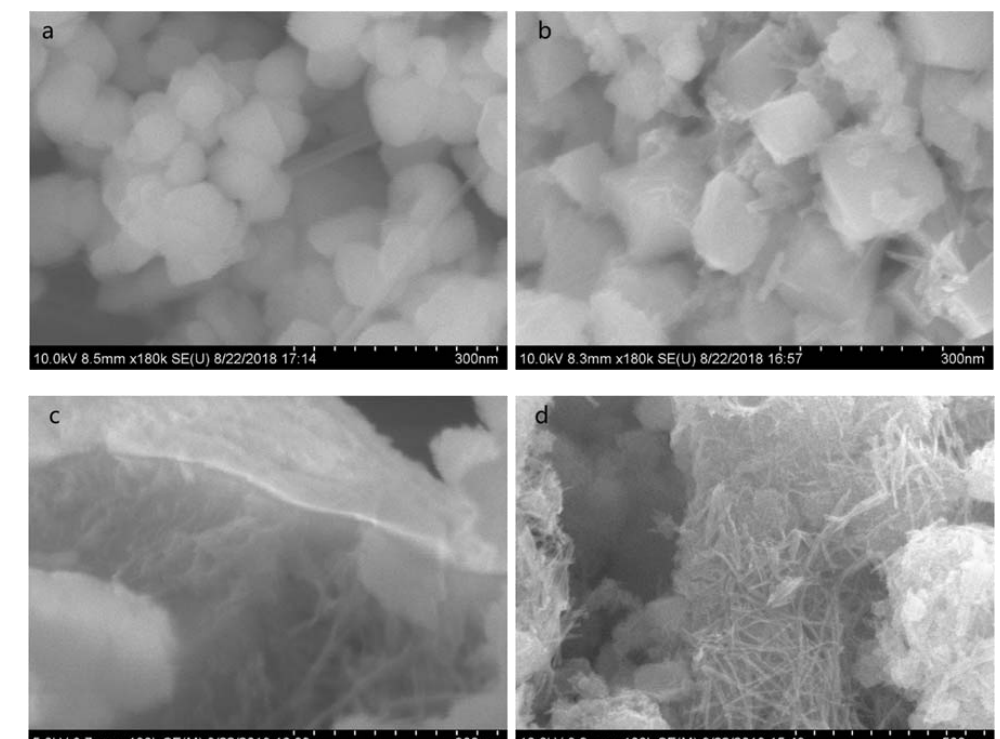
Figure 1. X ‐ ray diffraction patterns of prepared particles at various temperatures for 4 h. (From top to bottom: Commercial nanosized Mn 3 O 4 ; 170; 150; 130; 110